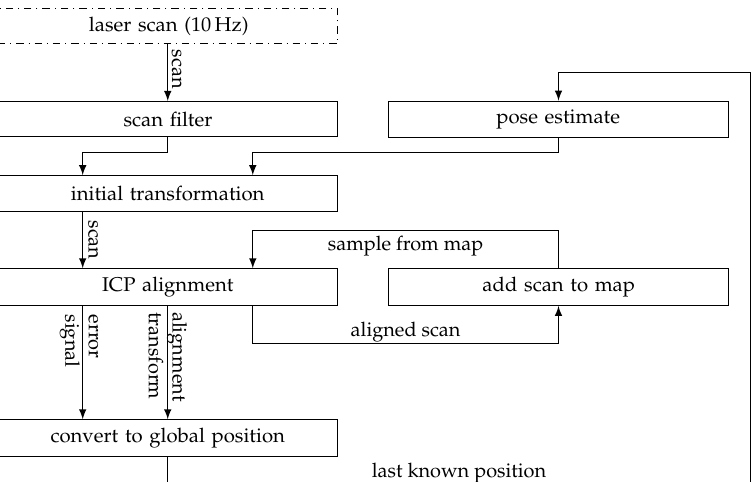
Figure 1. The flowchart visualizes the different steps of the developed RTOB-SLAM method. First the laser scan is filtered and pre-aligned with the map using the last known position. This initial aligment is then refined with the ICP technique.